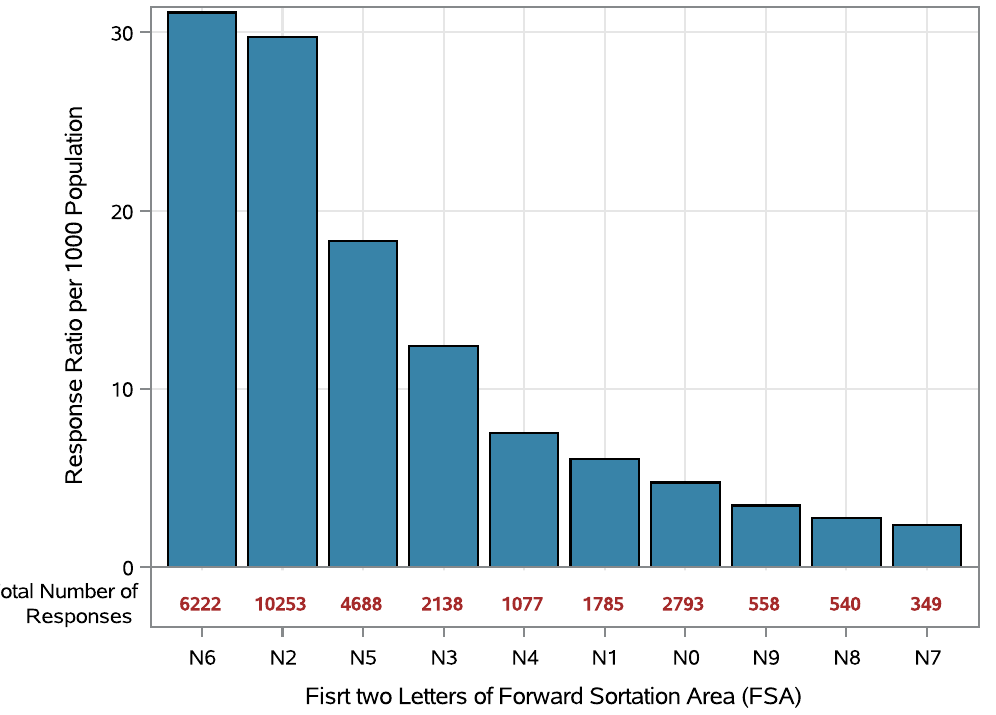
Figure 7. Portal responses per 1000 population by postal code sub-region.